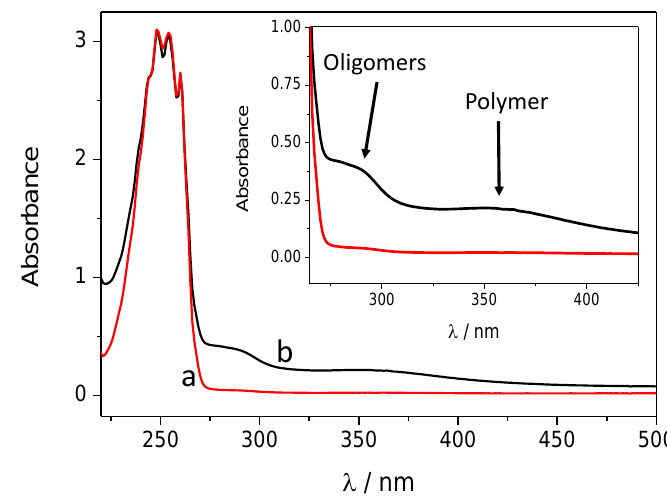
Figure 2. Ultraviolet-visible (UV-vis) spectra of the filtered and centrifuged dispersion after 60 min of illumination: ( a ) hard ultraviolet (UV)-filtered, ( b ) hard UV-illuminated.